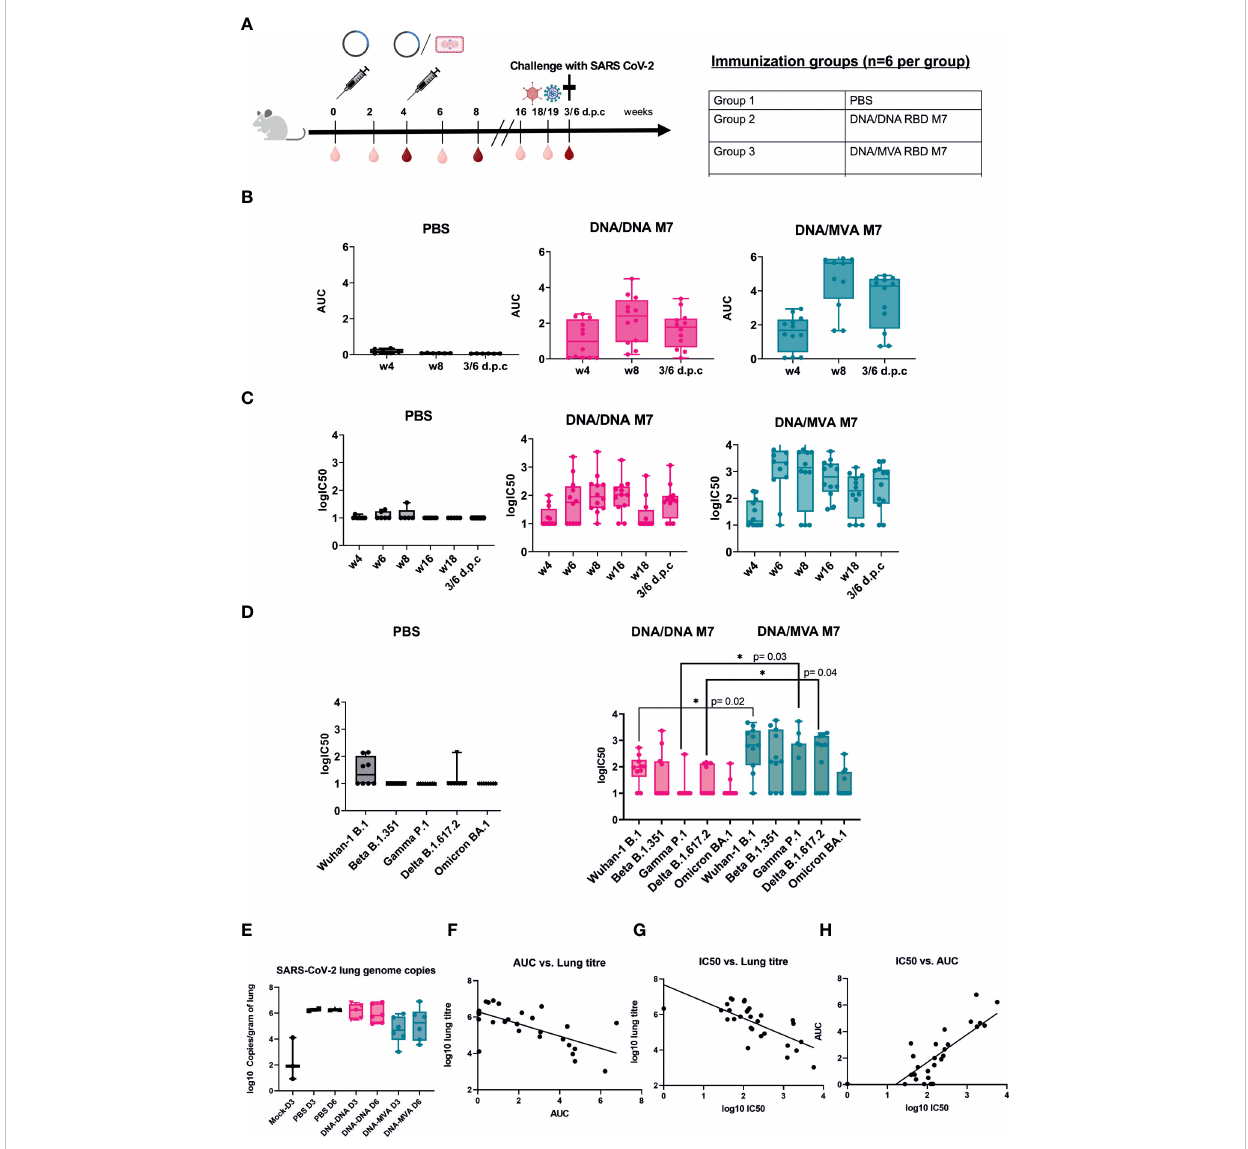
FIGURE 5 Challenge in human ACE2 transduced mice with SARS-CoV-2 wildtype virus. (A) Immunization schedule of BALB/c mice vaccinated (n=12) using different DNA prime/MVA boost regimen followed by a challenge with SARS-CoV-2 live virus. For challenge, BALB/c mice were transduced with 1x10 7 pfu of the ad5-huACE2 vector fi ve days before infection with 1x10 4 pfu Australia/VIC01/2020 SARS-CoV-2 virus. Bleeds were taken in two- week intervals (light red symbol) until week 8 and then again at week 16, 18/19 and 6 days post challenge (6 d.p.c). Bleeds at week 4, 8 and 6 d.p.c were analysed (dark red symbol). Binding antibody titers (AUC) (B) and neutralising antibodies (logIC50) (C) against SARS-CoV-2 were analyzed 4 weeks after prime and boost respectively and 6 days post challenge (d.p.c). (D) Neutralisation titers (logIC50) against all circulating VOCs to date analyzed in mouse sera obtained after 6 d.p.c. (E) SARS-CoV-2 genome copies from the lungs of infected mice at day 3 (D3) and day 6 (D6) post infection shown as log10 copies/gram of lung. (F – H) Correlation of binding (AUC) and neutralising (logIC50) antibody titer versus lung